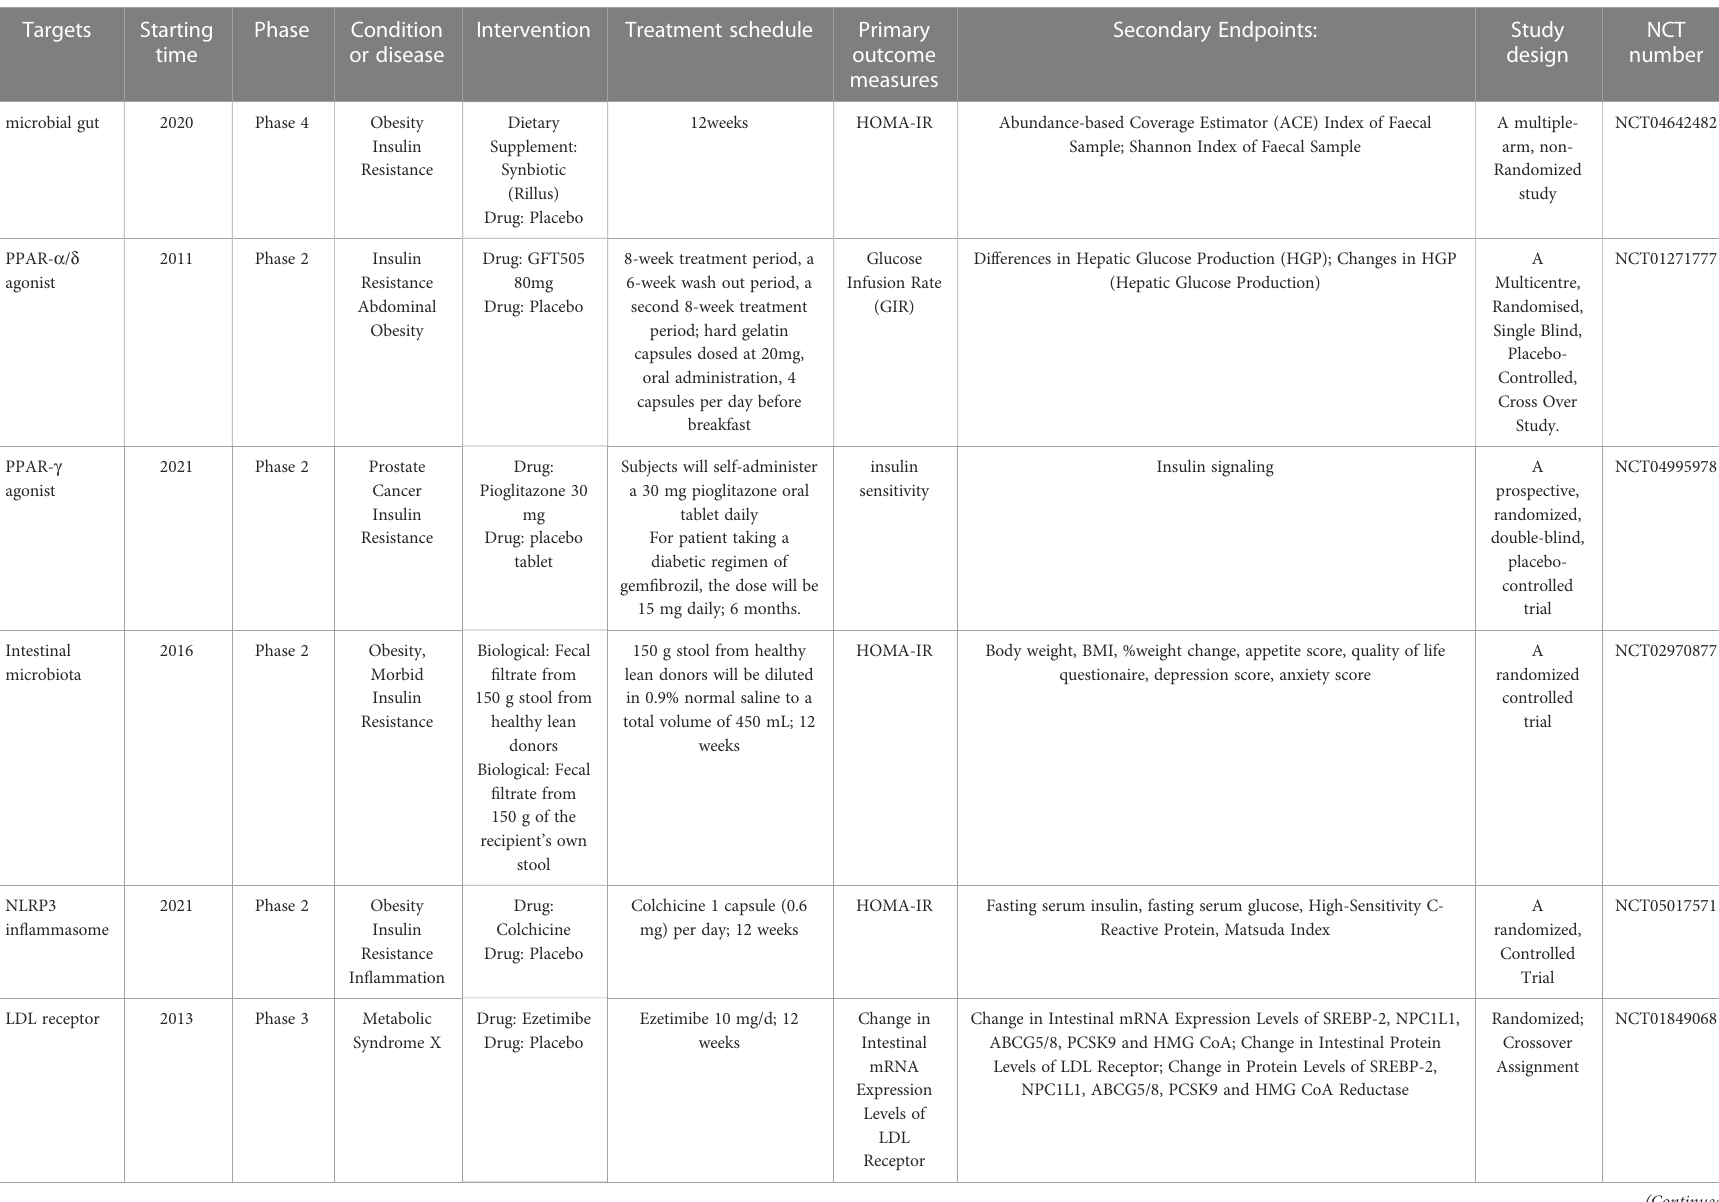
TABLE 2 Currently developing drugs targeting insulin